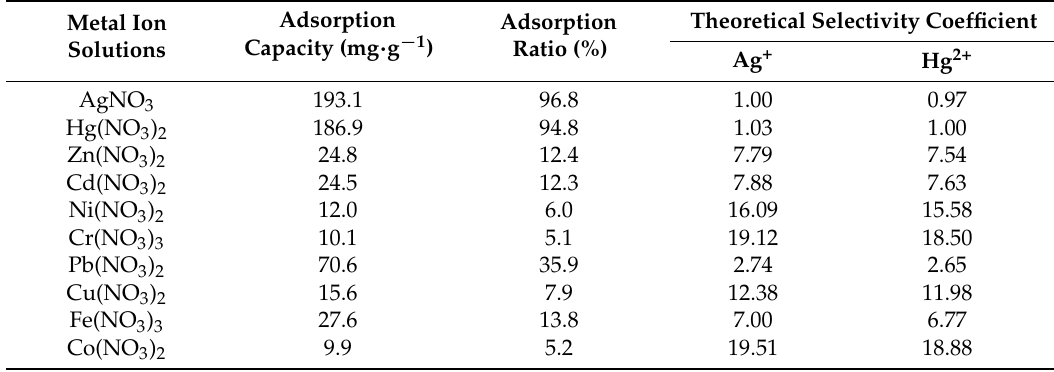
Table 1. Adsorption capacity and adsorption ratio of ten metal ions with an initial concentration of 200 mg · L − 1 for each metal ion at 25 ◦ C for 24 h with a poly-2-mercapto-1,3,4-thiadiazole (PTT) sorbent dosage of 1.0 g · L − 1